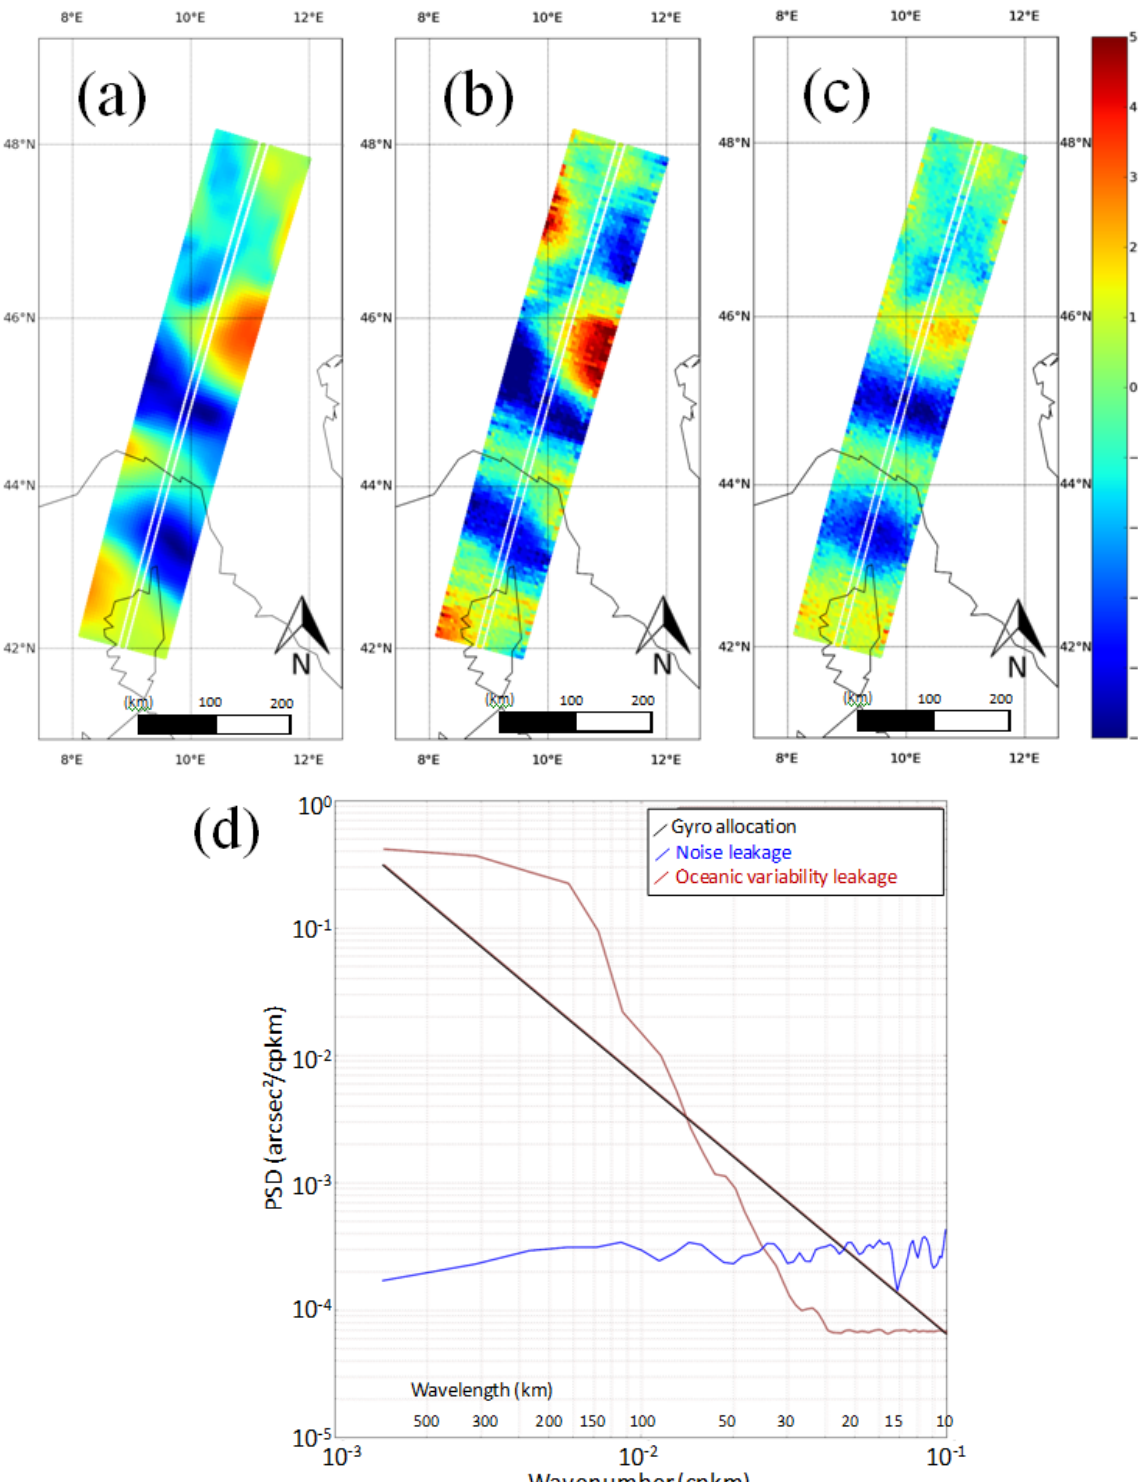
Figure 5. Spectral leakage generated by a linear fit with unweighted least squares on a simulated topography image. ( a ) is the true topography, ( b ) the measured topography (with roll and white noise), and ( c ) the topography after roll calibration (unit: cm). ( d ) shows the roll leakage PSD where KaRIN’s white noise (blue) or oceanic variability (red) are misinterpreted as roll noise because they have a non-zero cross-track